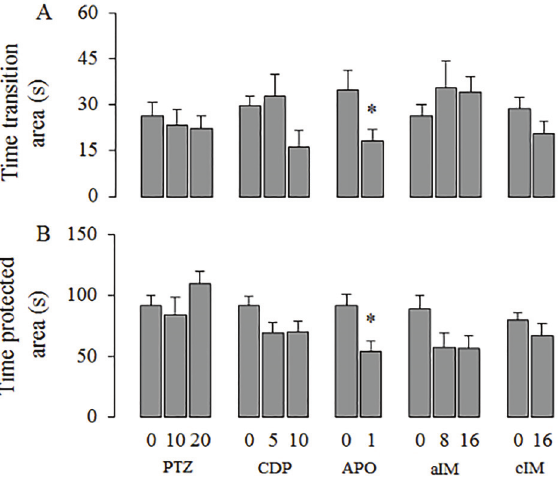
Figure 5. Effects of pentylenetetrazole (PTZ), chlordiazepoxide (CPD), apomorphine (APO), acute imipramine (aIM), and chronic imipramine (cIM) on the third factor (Self-protection). Data are reported as means ± SE. *P o 0.05 compared control vehicle. Statistical analysis was done with Student ’ s t